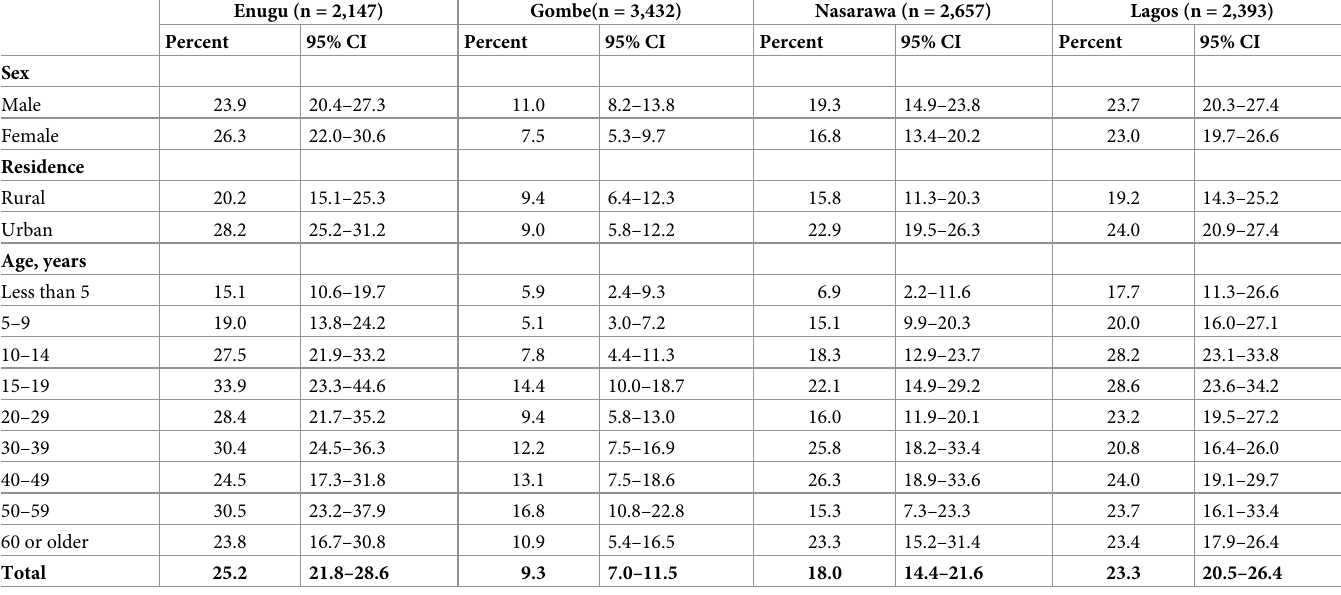
Table 2. Prevalence of SARS-CoV-2 antibodies among survey participants by state and demographic characteristics, Nigeria, October 2020 (n = 10,629). Enugu (n = 2,147)